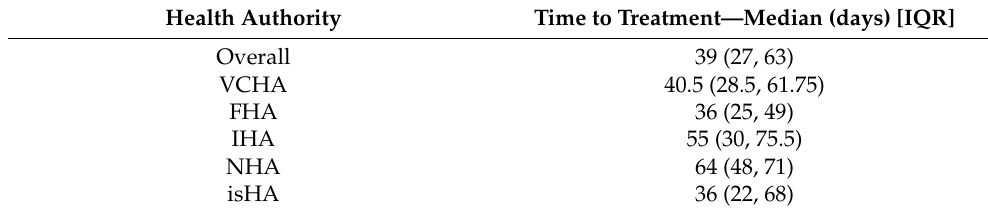
Table 3. Time to treatment among health authority